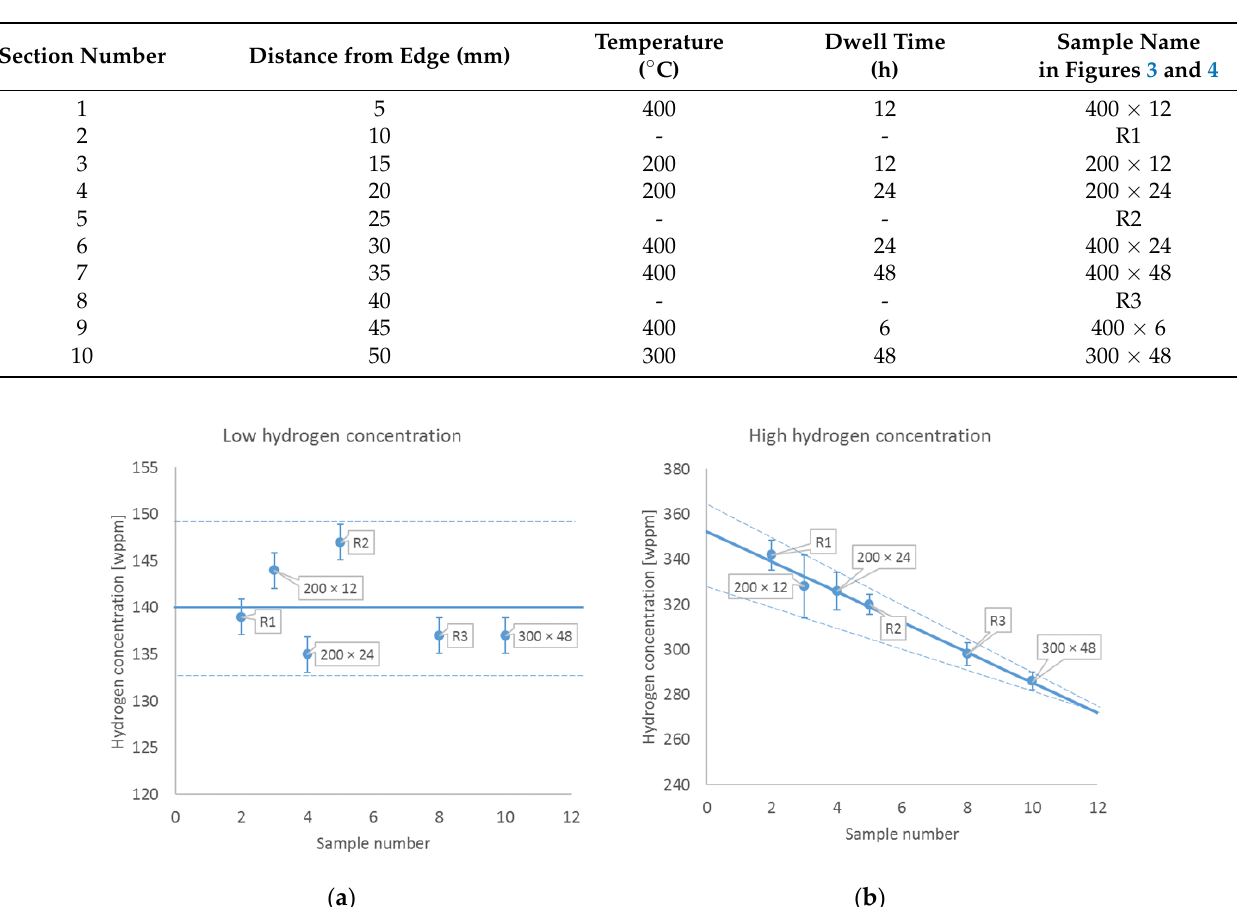
Figure 2. Cladding tube before hydrogenation (top) and after sectioning in 5 mm rings prior to de- sorption (bottom). Table 2. Test conditions and name adopted for each section for the low- (S100) and high-hydrogen (S350) tubes.